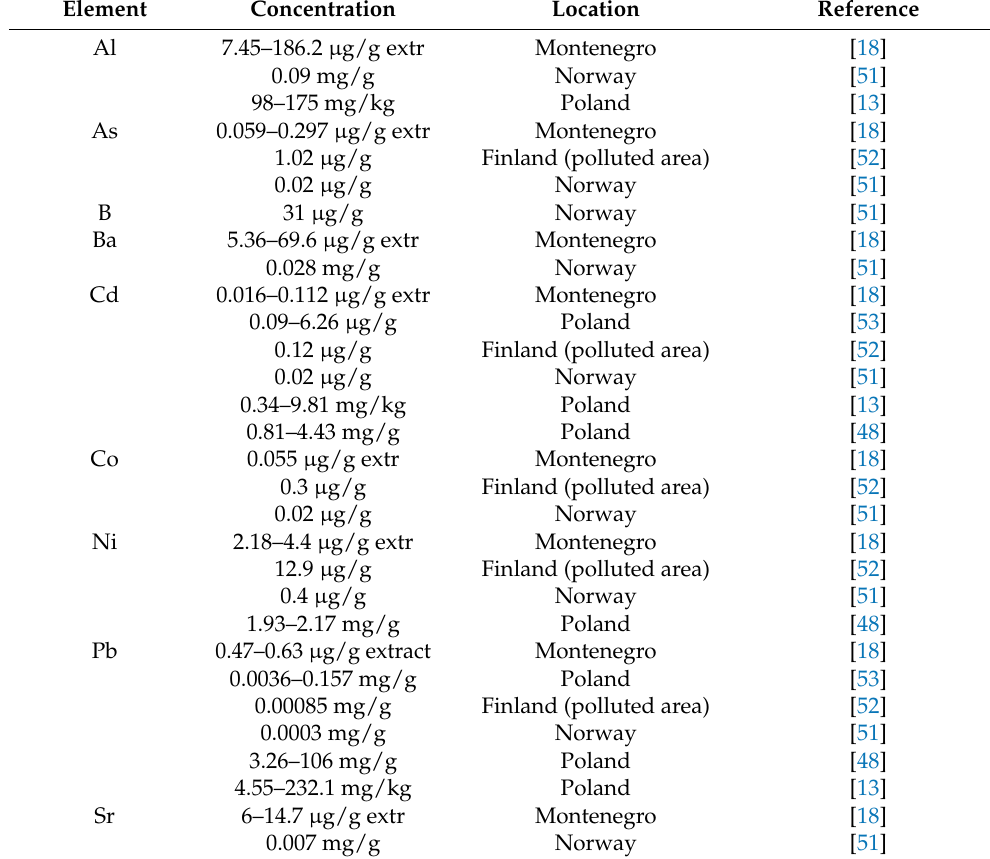
Table 7. Element concentrations in VM leaves collected from different